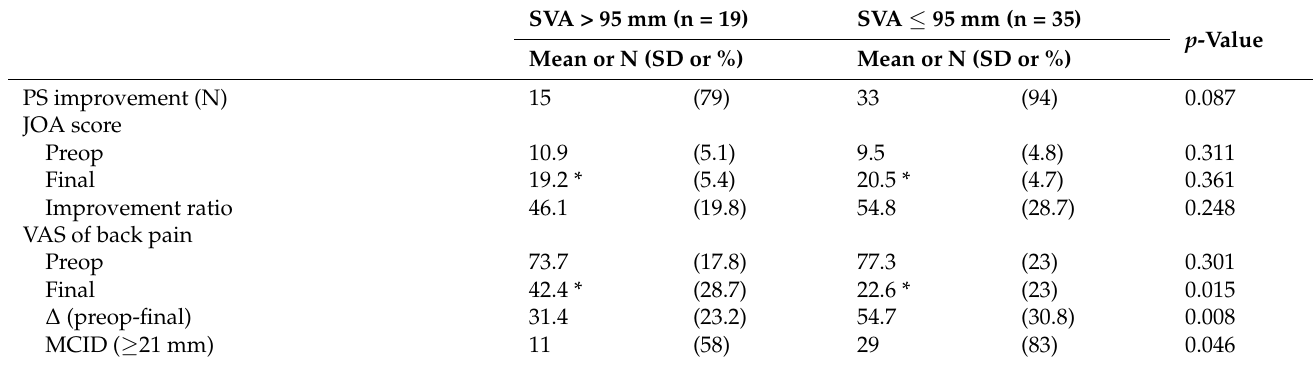
Table 3. Comparison of clinical outcomes between SVA > 95 mm and ≤ 95 mm